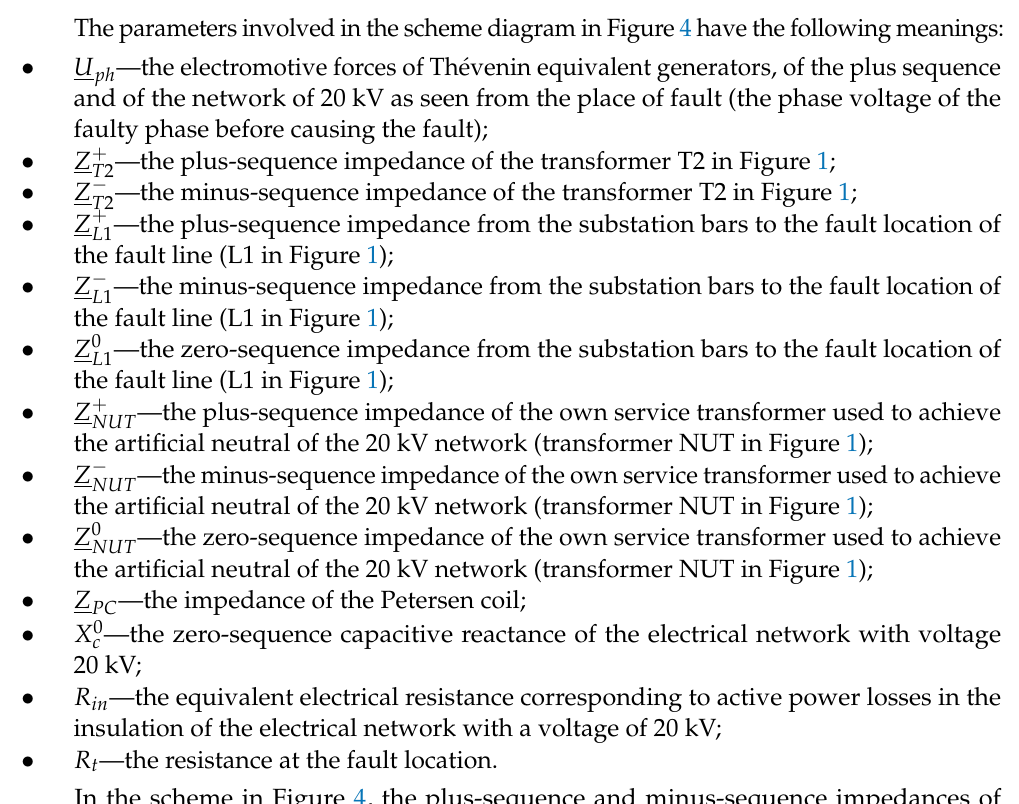
Figure 4. Equivalent sequence scheme for the single-phase fault in the 20 kV line.